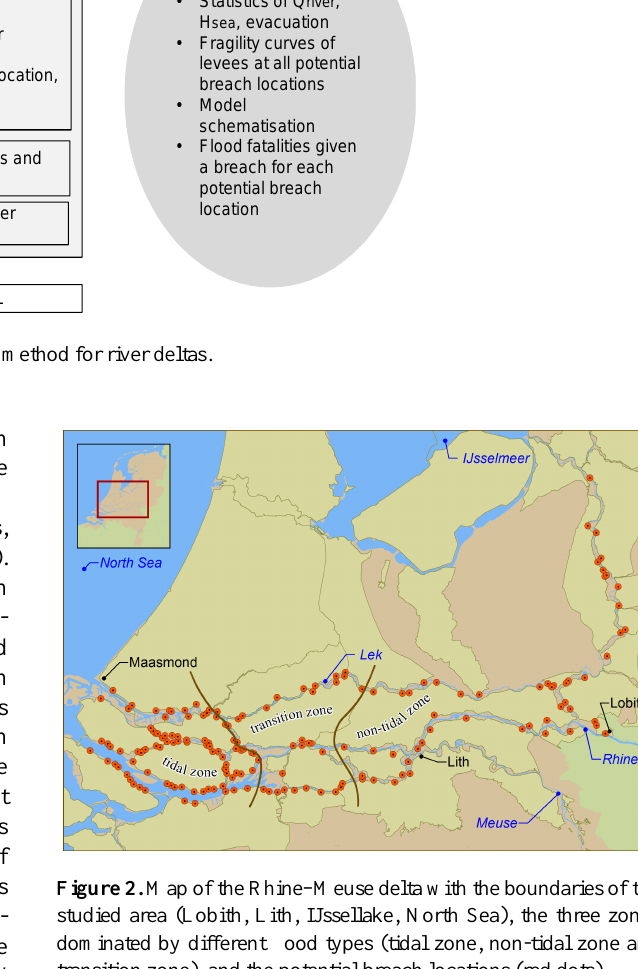
Figure 2. Map of the Rhine–Meuse delta with the boundaries of the studied area (Lobith, Lith, IJssellake, North Sea), the three zones dominated by different flood types (tidal zone, non-tidal zone and transition zone), and the potential breach locations (red